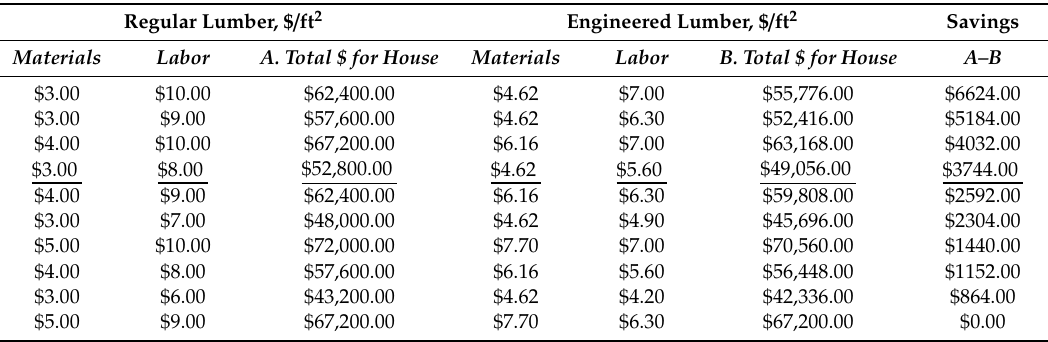
Table 3. Regular lumber versus finger-jointed studs cost per square foot of construction and